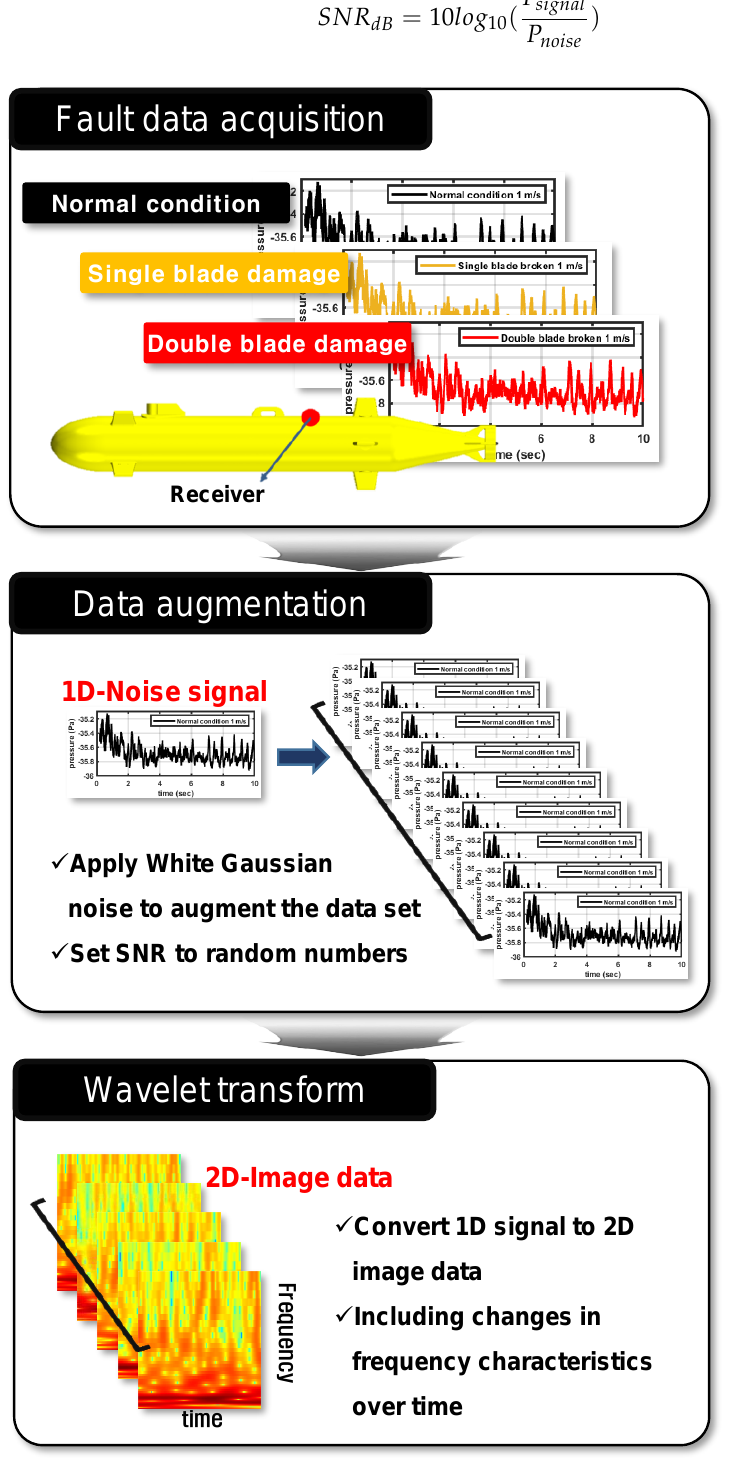
Figure 6. Procedure of the data acquisition